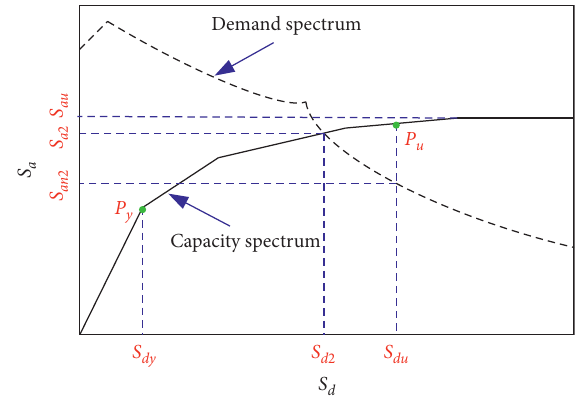
Figure 11: Check of design